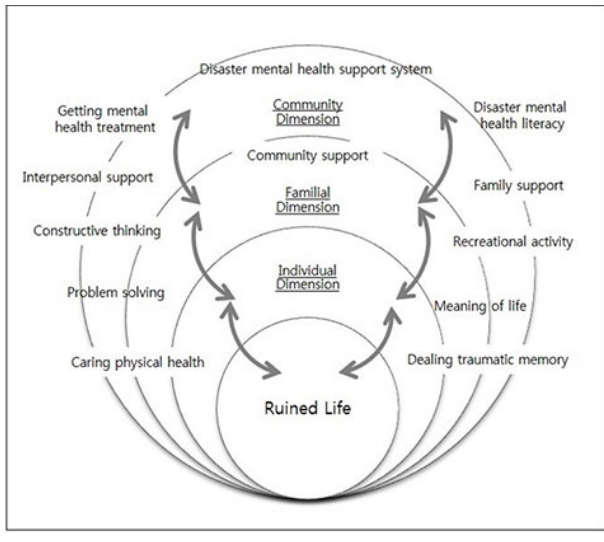
Figure 3. The conditional matrix of Korean’s coping process for mental health recovery from disaster.